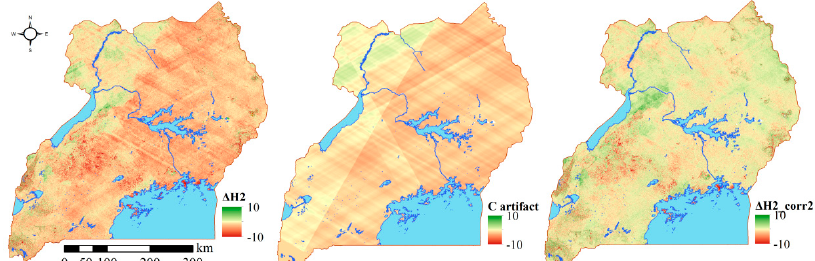
Figure 4. Map of Uganda with the height difference between the TanDEM-X DEM and the C-band SRTM DEM (left), the predicted errors identified by the ANOVA representing the line and belt artifacts of the SRTM C-band DEM (middle) and the residuals from the ANOVA representing Δ H2_corr2 .